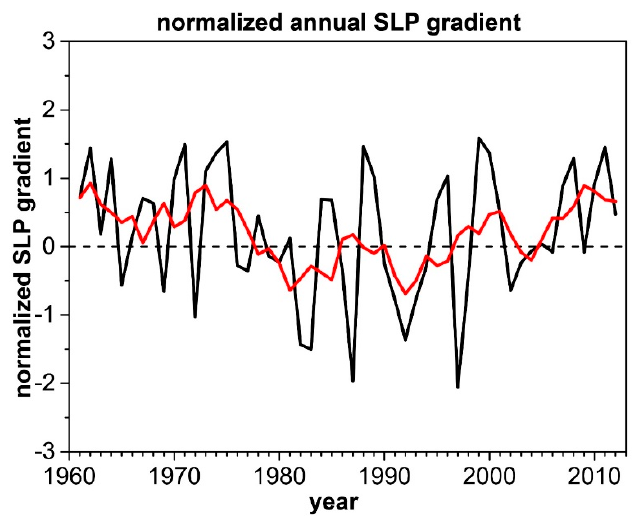
Figure 1. Time series of the normalized annual mean sea level pressure (SLP) gradient over the tropical Pacific (black line), defined as the mean SLP over the region (5° S–5° N, 80° W–160° W) minus the mean SLP over the region (5° S–5° N, 80° E–160° E) derived from the HadSLPr dataset [22] for 1961–2012. The red line represents the 5-year running mean of the SLP gradient.